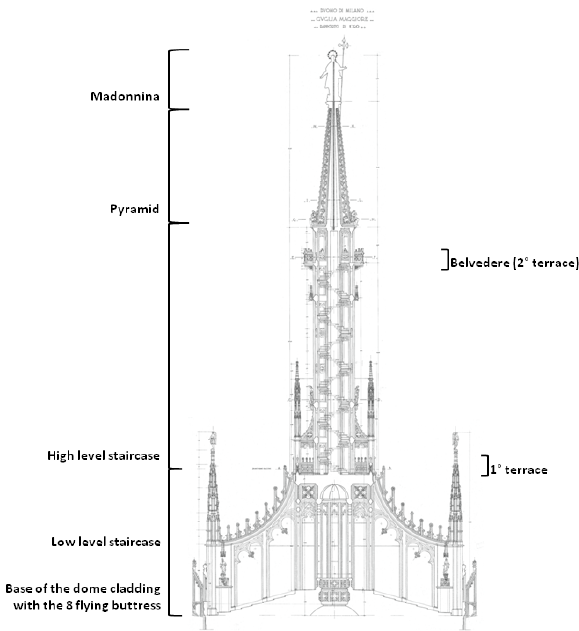
Figure 2: A diagram of the